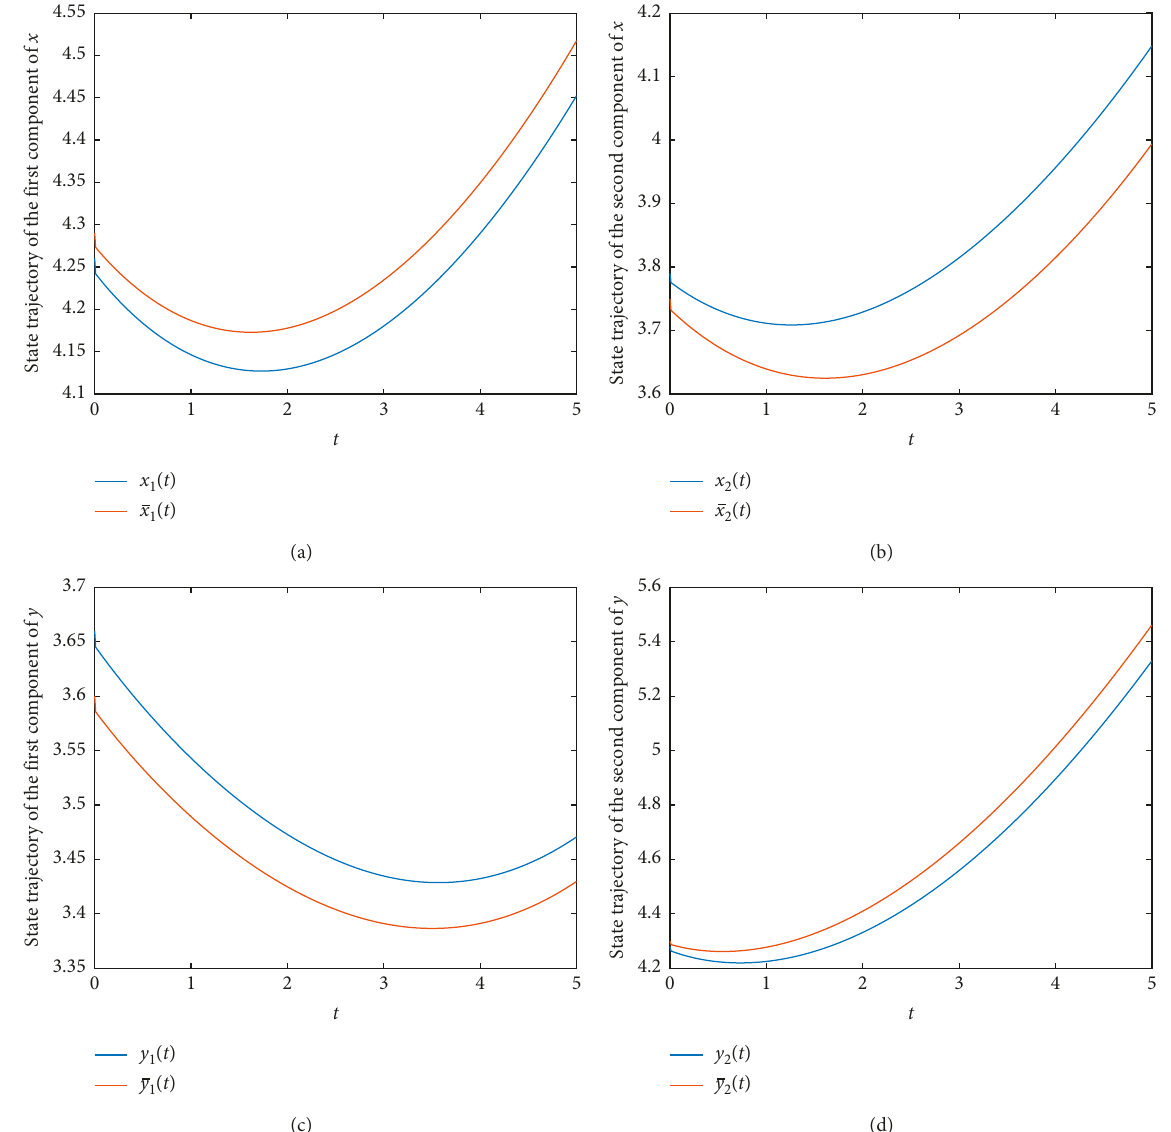
Figure 1: State trajectories of the system for two initial conditions in Example